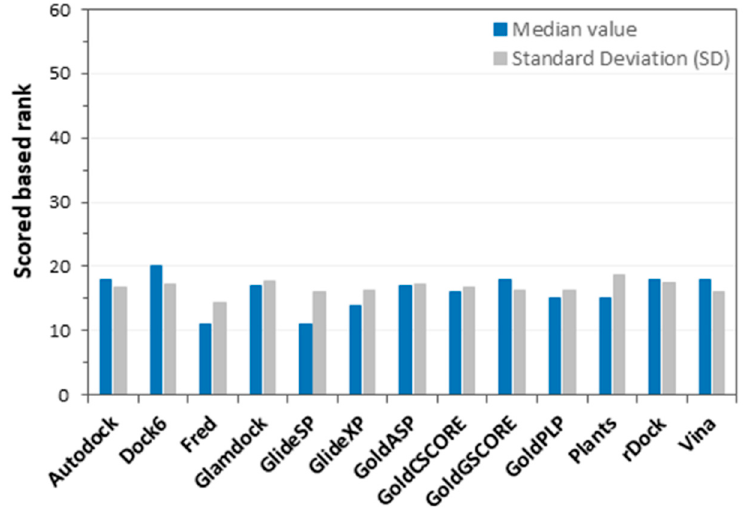
Figure 1. Results of the first docking score analysis. The blue bars represent the median ranking positions of true targets, calculated for each docking procedure by computing the median value of the single score ranking positions obtained for each ligand (600 ligands docked into 60 different targets). Grey bars stand for SD; namely, the dispersion of the ranking position values calculated for the 600 ligands in each docking procedure.